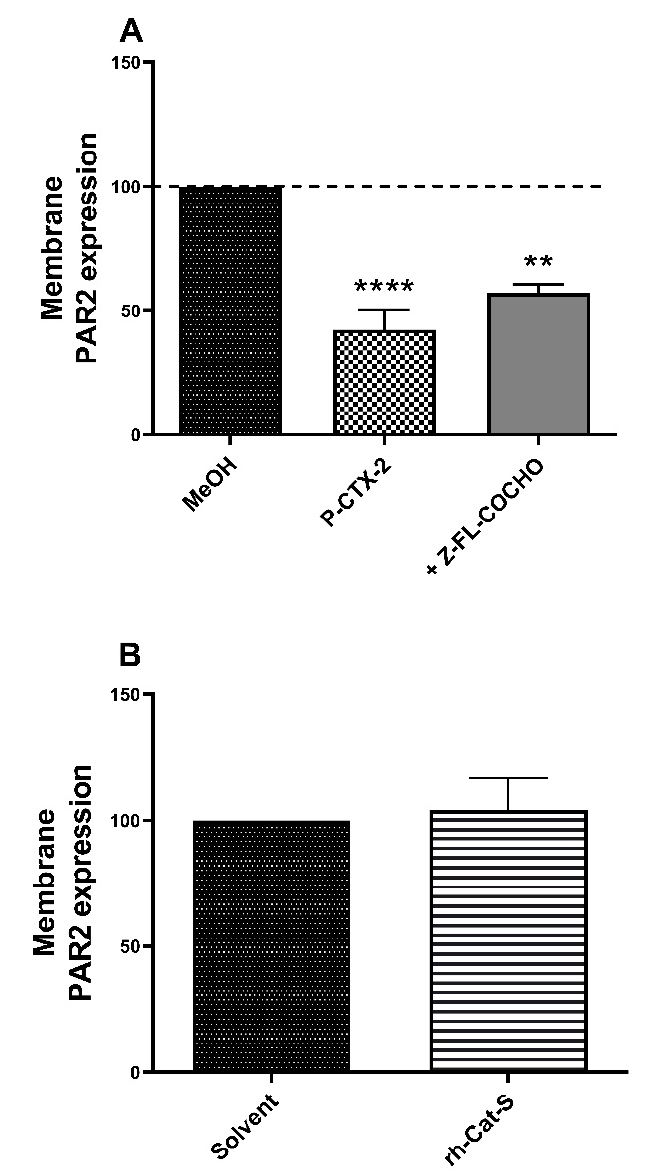
Figure 4. PAR2 internalization induced by P-CTX-2 is Cat-S-independent. ( A ) E ff ects of 10 nM of P-CTX-2 with or without pre-treatment of 10 nM of Z-FL-COCHO on PAR2 membrane expression in DRG neurons. Normalized data were expressed as mean ± SEM of 3 experiments and statistically analyzed using a one-way ANOVA followed by a Holm-Sidak test for multiple comparisons to control and between P-CTX-2 and P-CTX-2 / Z-FL-COCHO. ** p < 0.01, **** p < 0.0001. ( B ) E ff ects of human recombinant Cat-S on the PAR2 membrane expression in di ff erentiated human keratinocytes. Five hundred nM of human recombinant Cat-S were added for 20 min. Normalized data were expressed as mean ± SEM of two experiments. Cat-S: cathepsin S; CTX: ciguatoxin; P-CTX-2: Pacific-CTX-2; PAR2: protease-activated receptor 2; rh-Cat-S: human recombinant cathepsin S.